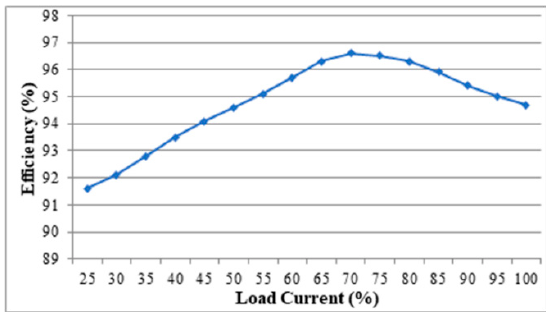
Figure 17. Waveforms at rated load: (1) V o 1 ; (2) I LS 1 ;(3) V o 2 ; (4) I LS 2 .